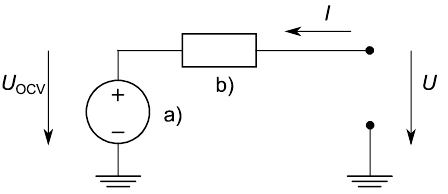
Figure 1. An equivalent schematic of the electrical characteristics of a lithium-ion battery cell. The schematic representation was composed of ( a ) a voltage source for the open-circuit voltage U OCV in series with ( b ) the equivalent battery cell internal resistance. The terminal voltage of the battery is indicated with U . In the actual case, this system was extended by charge dependent behavior of ( a ) and charge behavior of ( b ).